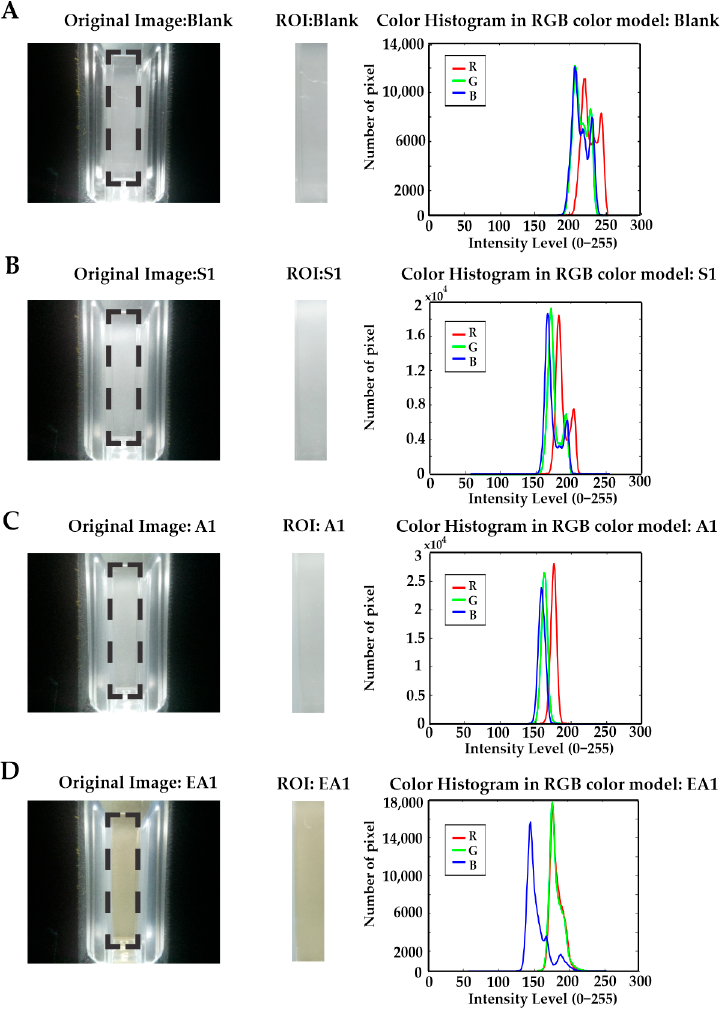
Figure 3. Representative images of ( A ) Blank solution, ( B ) Silver tequila, ( C ) Aged tequila, and ( D ) Extra-aged tequila samples. The image captured by the Electronic Eye (EE), region of interest (ROI) and Red, Green, and Blue (RGB) intensity histogram is noted from left to right.